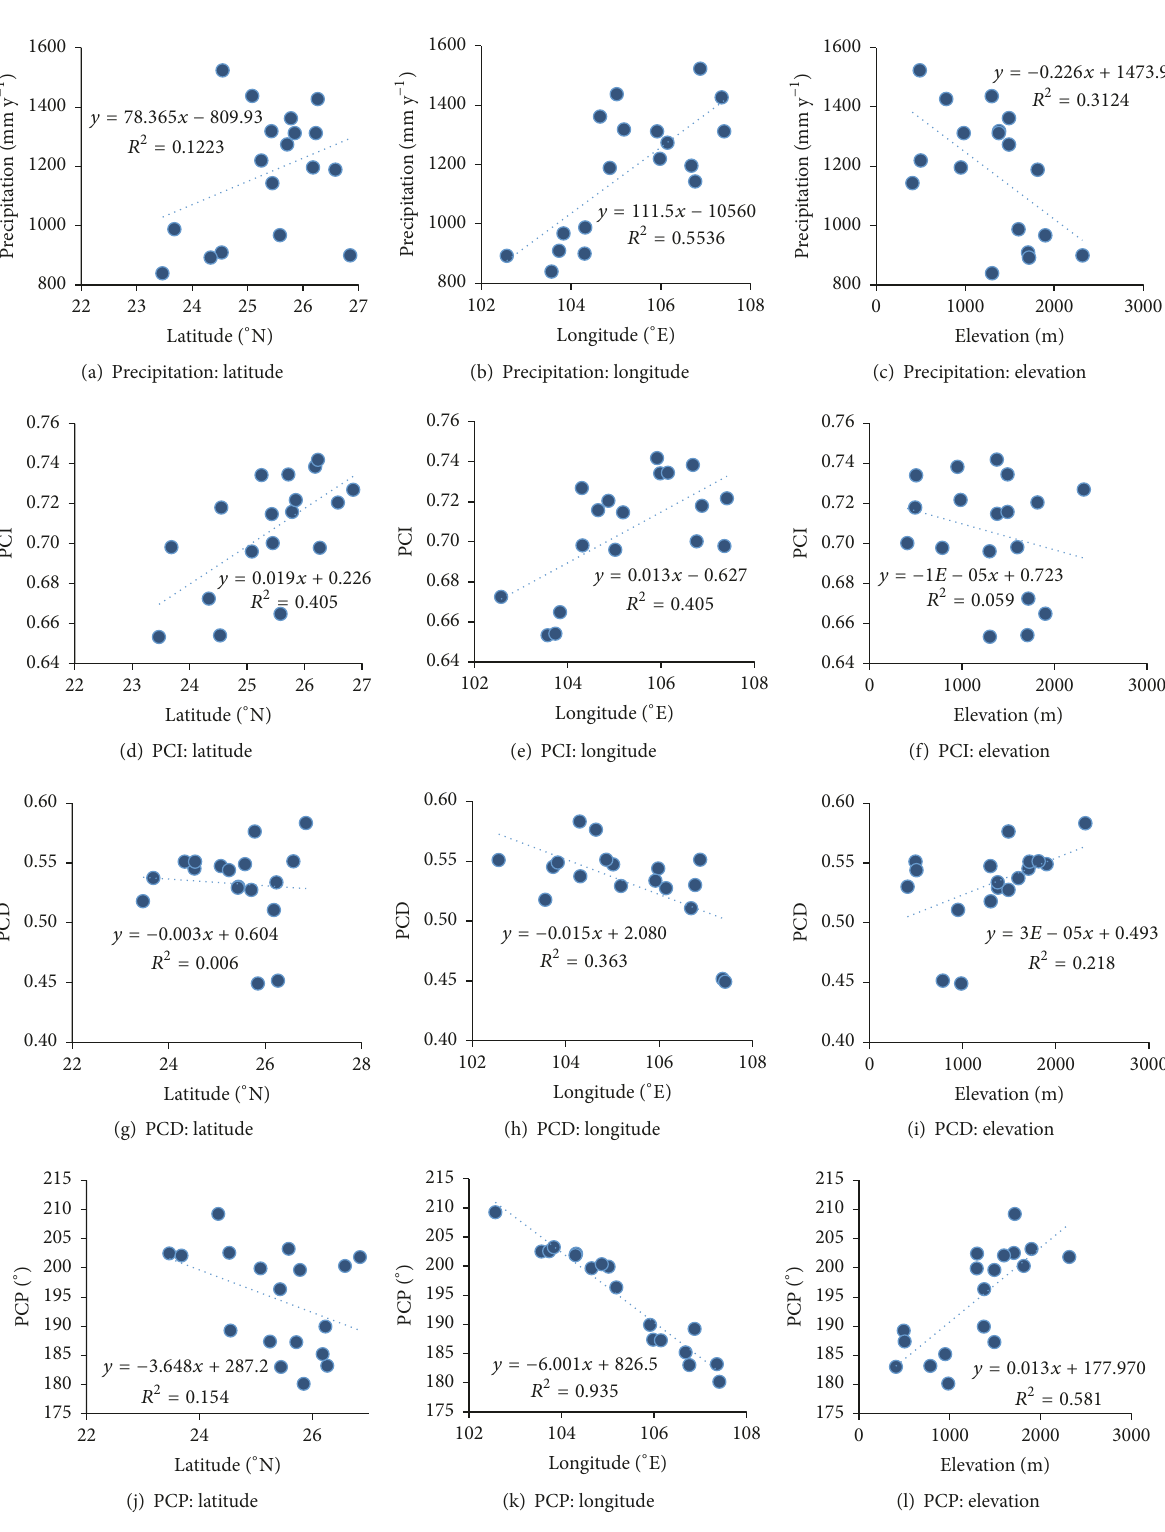
Figure 5: Correlations between geographical features (from left to right: latitude, longitude, and elevation) and (a–c) mean annual precipitation, (d–f, g–i, and j–l) PCI, PCD, and PCP,